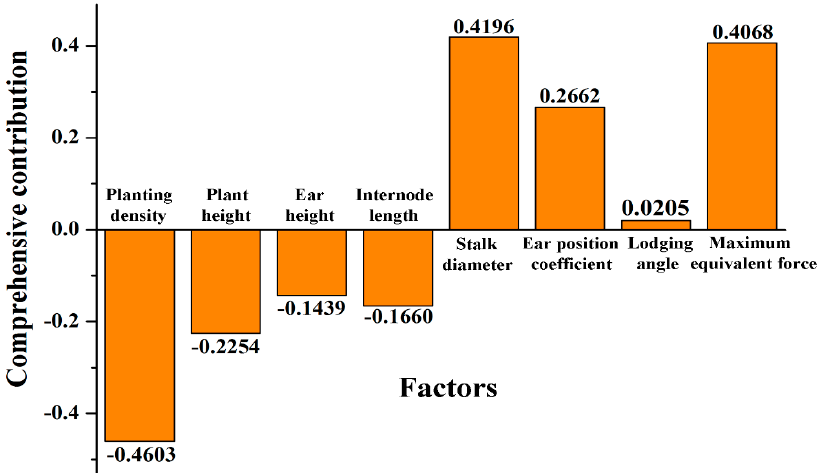
Figure 4. Comprehensive contribution of various factors affecting the corn stalk lodging